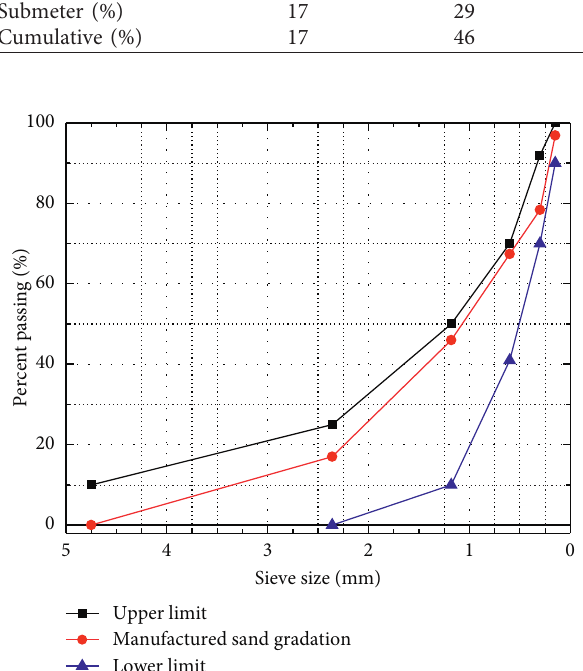
Figure 2: Gradation of manufactured sand used in this study.